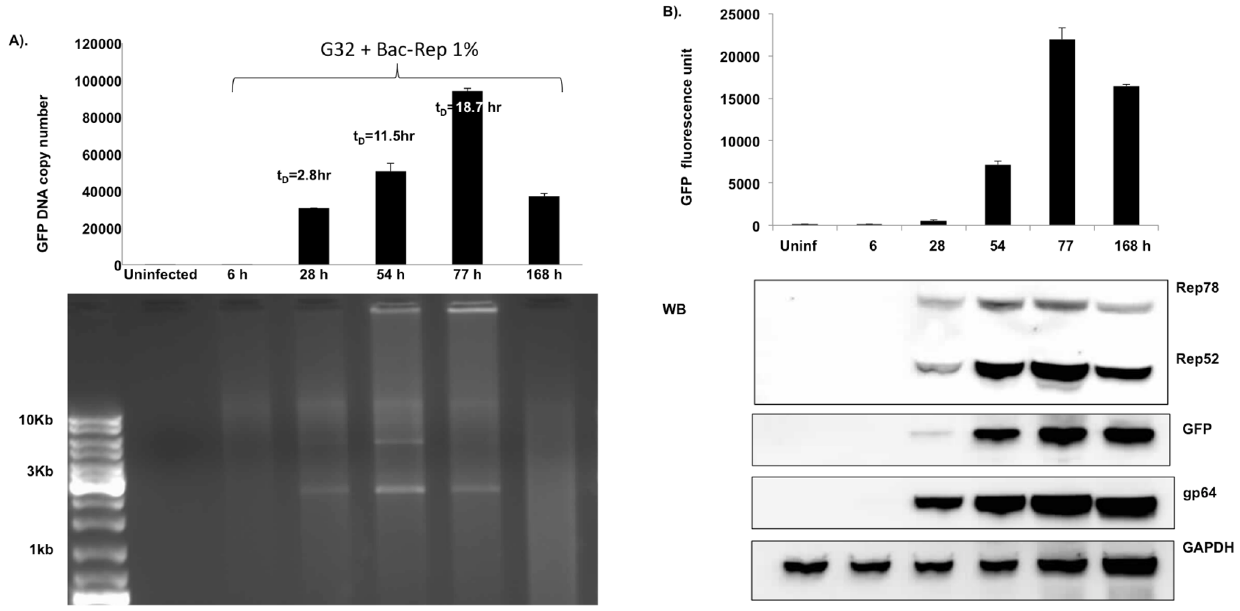
Figure 3. Rate of GFP vector DNA accumulation. (A). Cells were inoculated with 1% (v:v) Bac-Rep stock and sampled at 6, 28, 54, 77, and 168 hr post-infection. The GFP-vector DNA content was determined by qPCR (upper panel). The doubling time of the GFP vector DNA was determined using the following algorithm: t D = (t 2 –t 1 ) log 2/log (t 2 /t 1 ), where t D is the doubling time and t n is the GFP copy number at a given time point. The t D (28 hr) =2.8 hr, t D (54 hr) =11.5 hr, and t D (77 hr) =18.7 hr. (B) Time course of protein expression in Sf9/ITR-GFP cells. GFP fluorescence was measured in cell lysates obtained from the time-course described in (A) (upper panel). Aliquots from each time point were fractionated on SDS- polyacrylamide gels and transferred to nitrocellulose membranes for western blot analysis to detect Rep proteins, GFP proteins, gp64, and